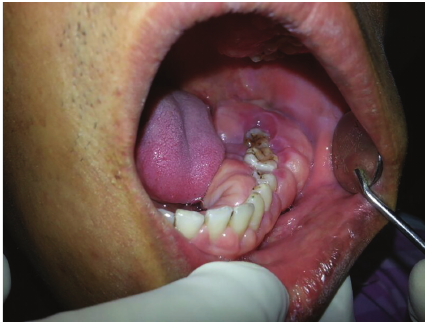
Figure 4: Operative